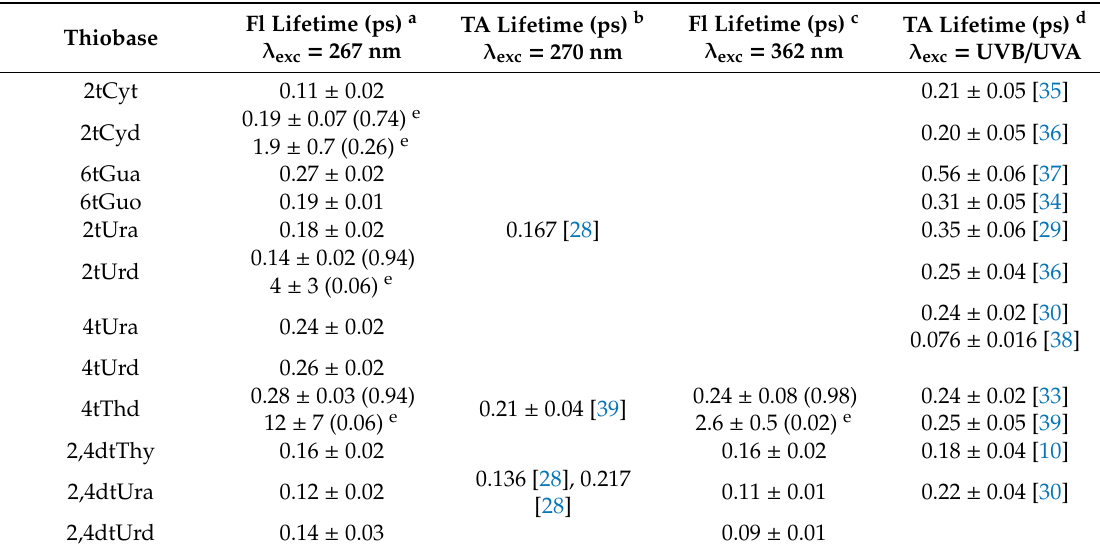
Figure 4. E ff ect of solvent environment on the fluorescence decay of ( a ) 4tThd, ( b ) 4tUrd, and ( c ) 4tUra. Fluorescence decay lifetimes were measured in PBS at pH 7.4 and in acetonitrile (ACN), exciting at 267 nm and a detecting emission at 380 nm. Table 1. Fluorescence (Fl) and transient absorption (TA) lifetimes of the thiopyrimidine and thiopurine derivatives in PBS at pH 7.4. The relative amplitudes for biexponential lifetimes are reported within parentheses. Uncertainties for the fluorescence lifetimes correspond to one standard